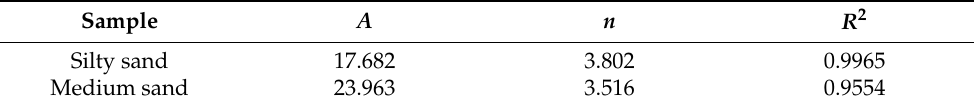
Table 4. Fitting parameters of the empirical relationship between G max and effective pressure for silty and medium sand in the East Nan-ao area.